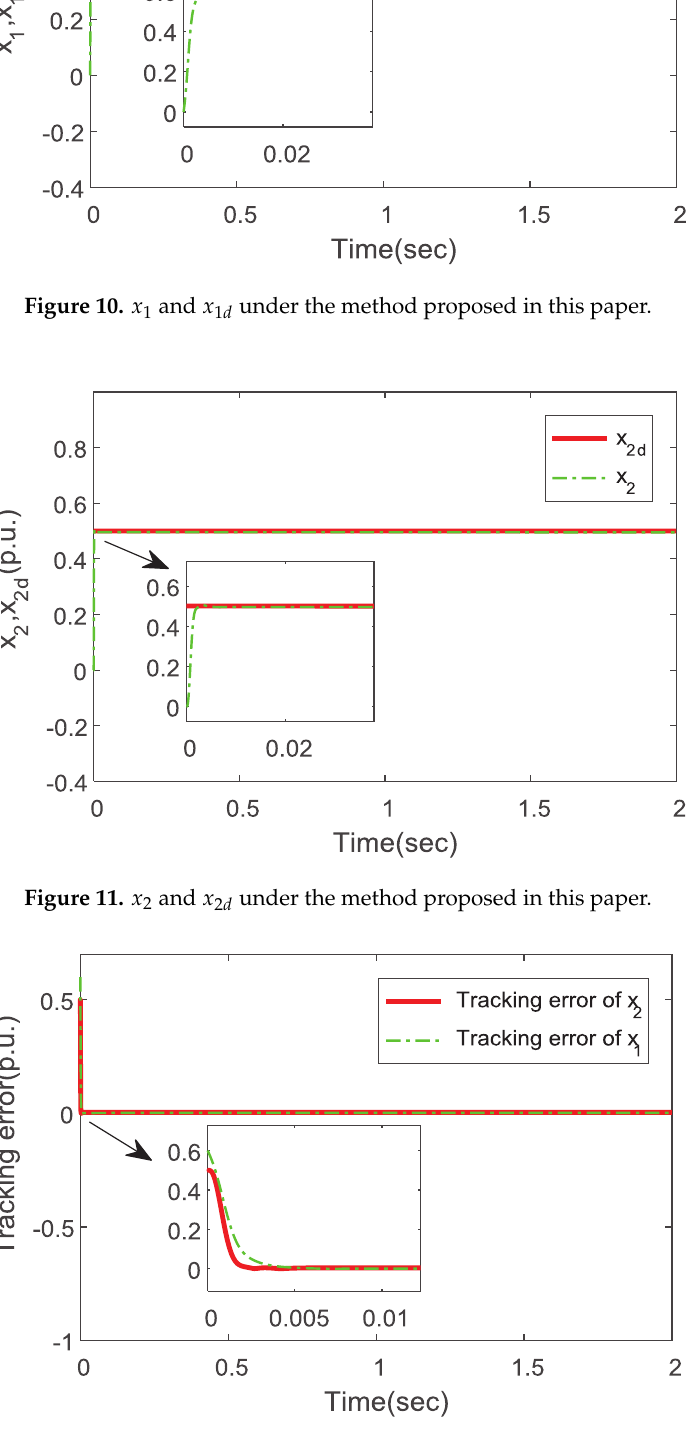
Figure 12. Tracking error waveform of x 1 and x 2 in this